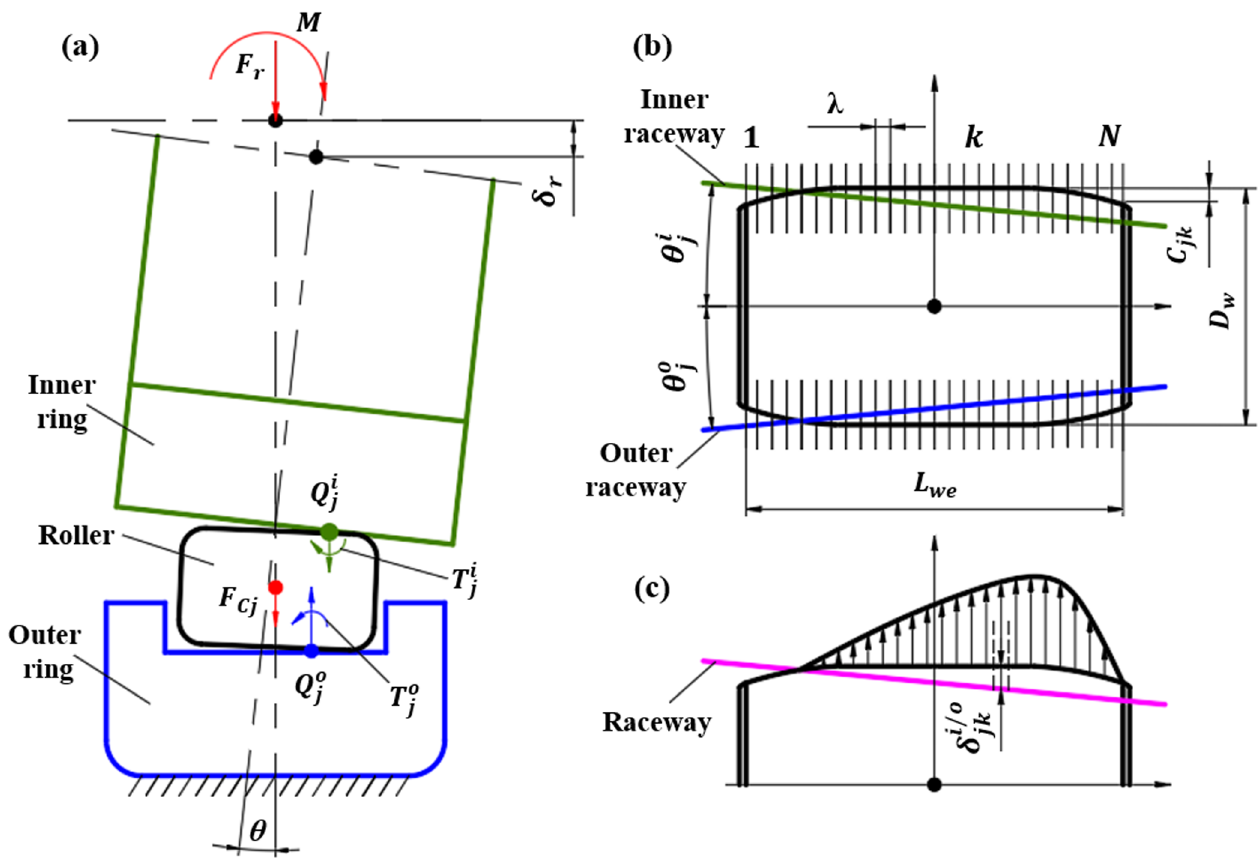
Fig. 4. Schematic diagram of bearing contact model: (a) bearing cross-section geometry and roller force; (b) schematic diagram of slicing method; (c) schematic diagram of contact